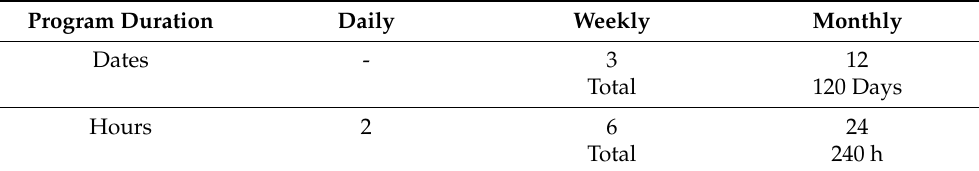
Table 1. Planned youth volleyball training schedule at Amhara Regional State, Ethiopia. Program Duration Daily Weekly